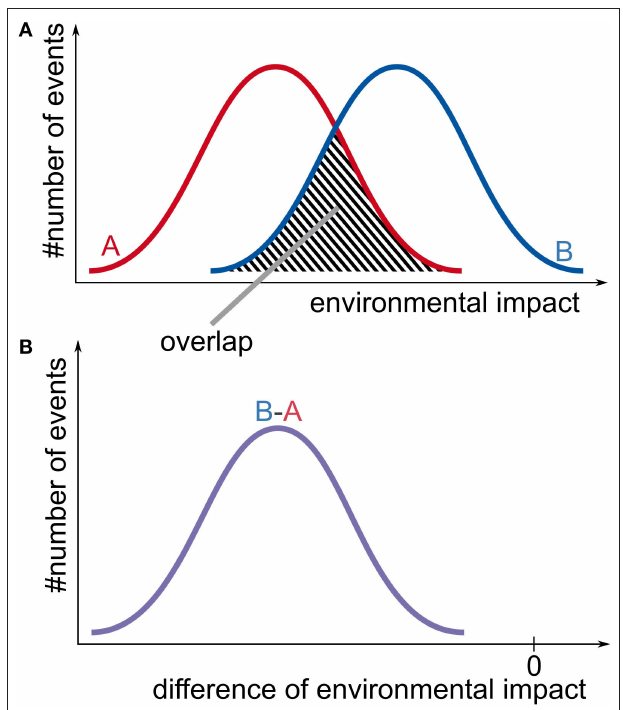
FIGURE 10 | (A) Results of an independent Monte Carlo analysis for alternatives A and B. (B) Results of Monte Carlo analysis for the difference of